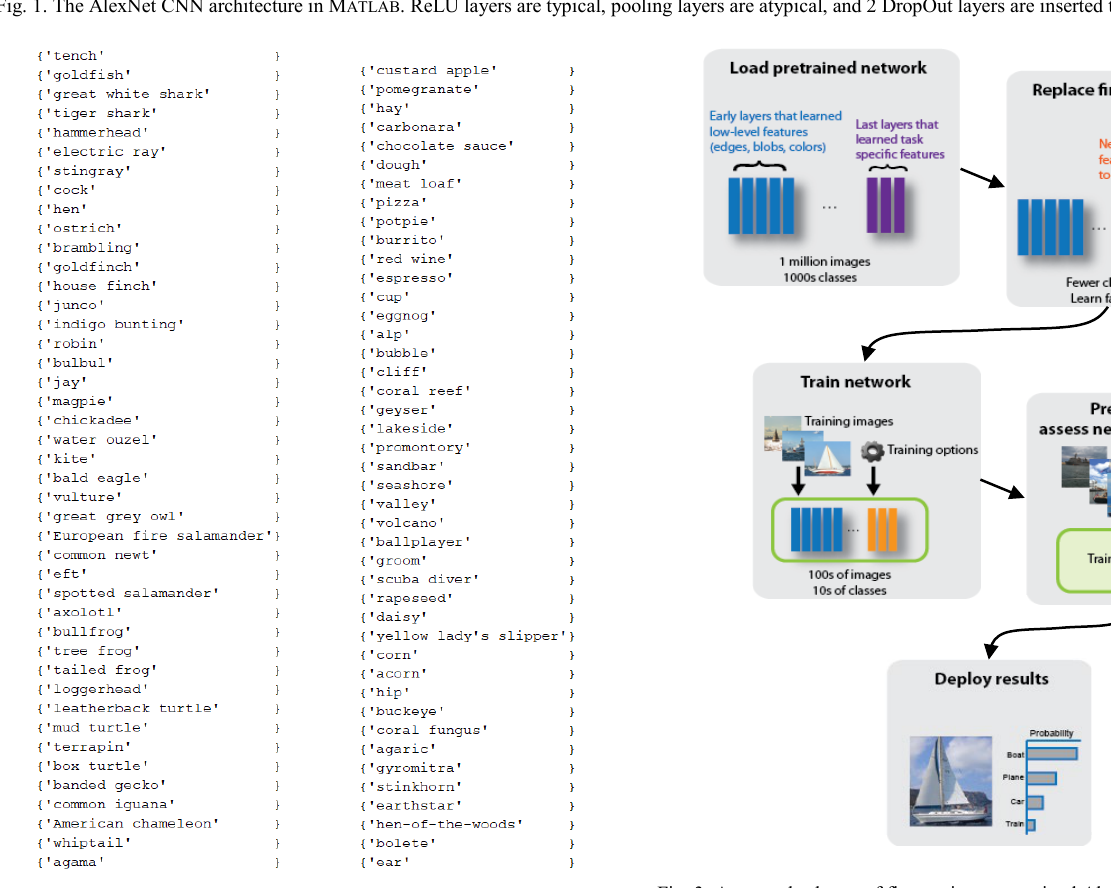
Fig. 2. The first 43 and last 43 object categories of the AlexNet CNN. Some really vast objects, like “lakeside”, “seashore”, “valley”, etc., are true scenes.